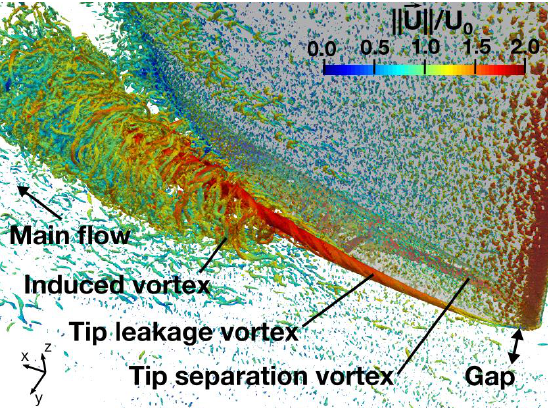
Figure 3. LES instantaneous iso-surfaces of Q criterion (Q = 3.0 × 10 2 (U 0 /c) 2 ) coloured by the velocity magnitude in the tip leakage flow